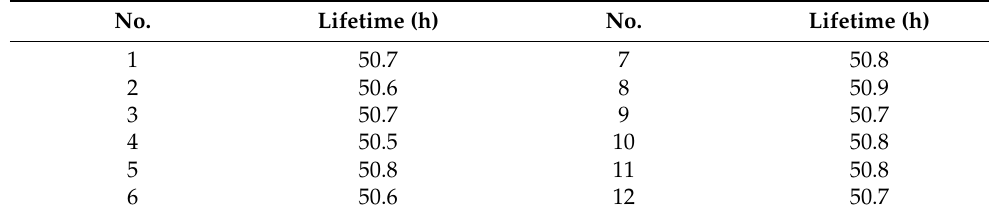
Table 6. Results of the WSND lifetime in HVDC test base.